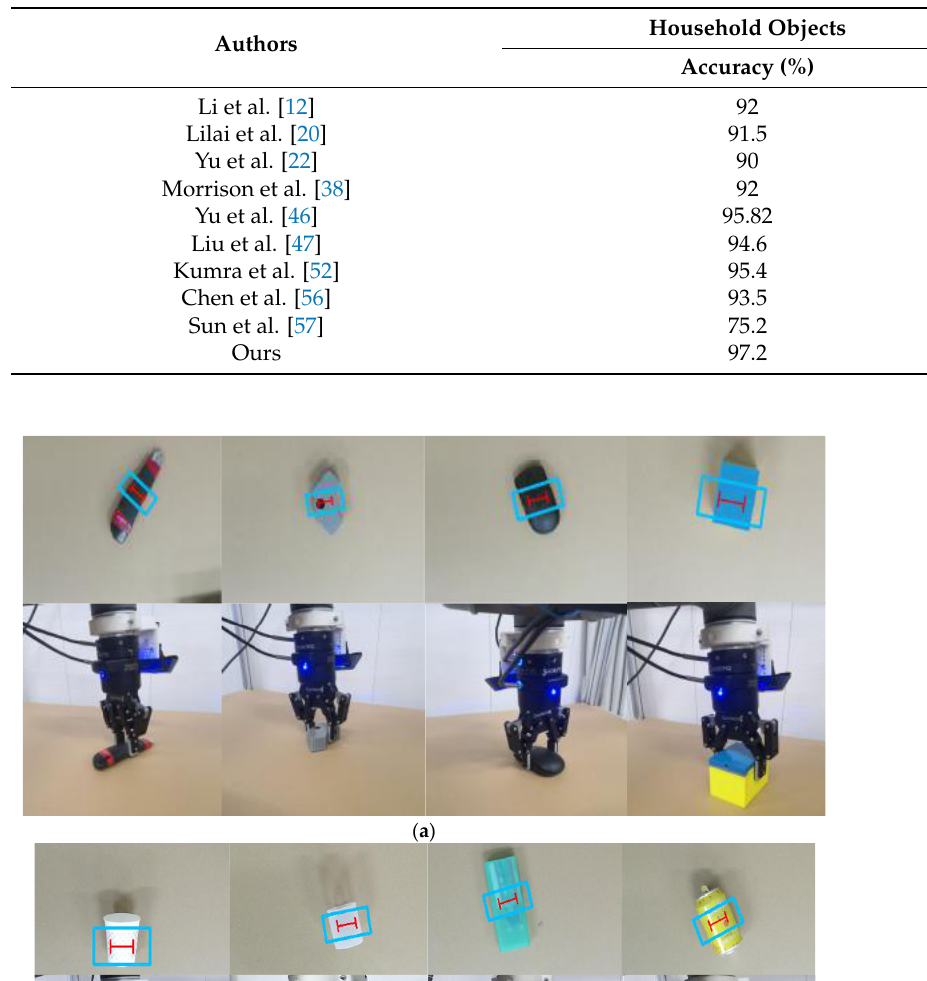
Table 5. Results on single objects.